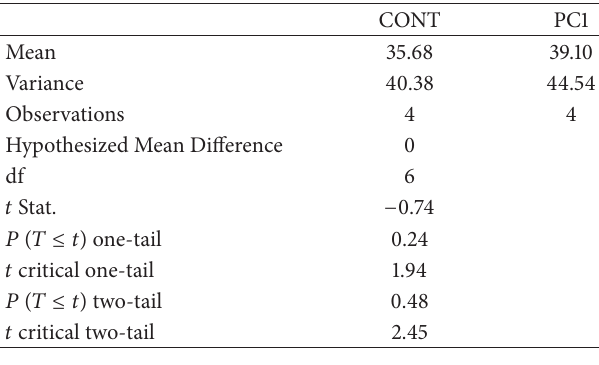
Table 7: 𝑡 -test assuming unequal variance, autogenous shrinkage.